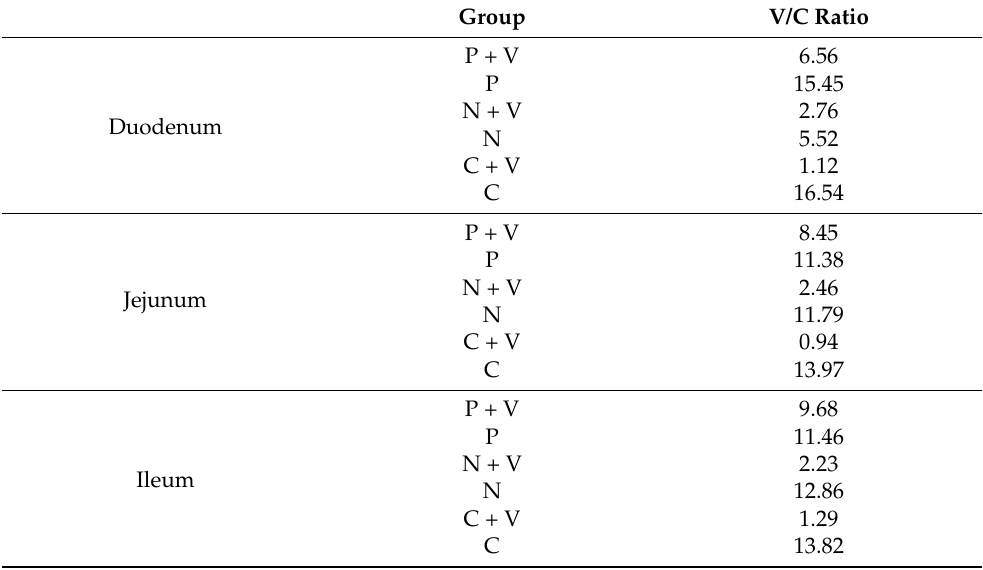
Figure 8. Effects of the double-shRNA-N1-expressing plasmids treatment on piglet intestinal changes. At 48 h post-challenge, all the piglets were euthanized and necropsied to examine the macroscopic lesions. No visible gross lesions in the small intestines were observed in the piglets in the P + V, P, N, and C groups ( a , d – f ). Meanwhile, the small intestinal walls of the piglets in the N + V and C + V groups were thin and transparent ( b , c ). Table 4. Effects of the different treatments on villus height and crypt depth of the small intestines of the